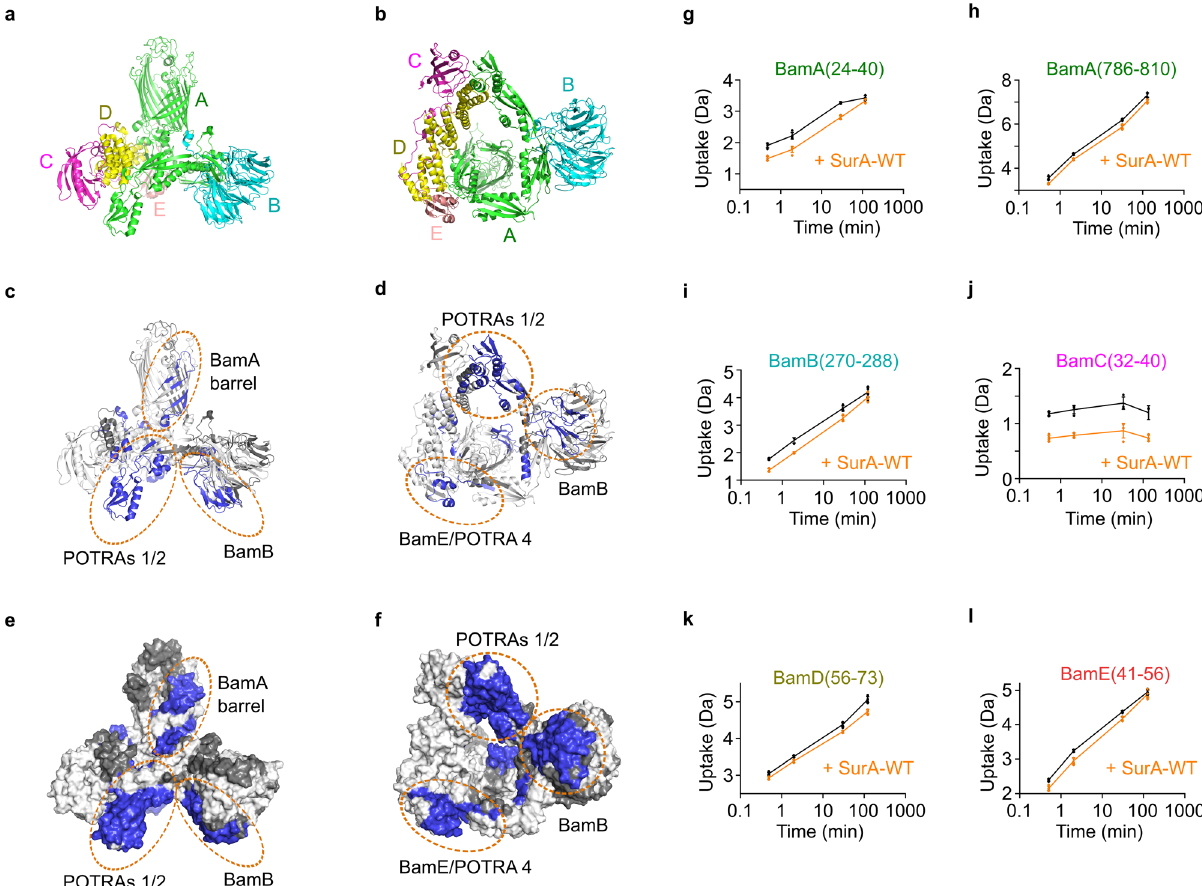
Fig. 2 HDX-MS analysis of BAM in the presence of SurA reveals multiple chaperone binding sites and allosteric conformational changes. a , b The structure of the BAM complex in the ‘ lateral-open ’ conformation (PDB: 5LJO 13 ) coloured by subunit. c , d Cartoon views and e , f surface views showing regions of HDX protection in the BAM complex upon binding SurA. Left panels show a side view of the complex, and right panels a view from the periplasmic face. Regions that are protected from hydrogen exchange in the presence of SurA are highlighted in blue. Regions in white show no change in deuterium uptake in the presence of SurA, while those in dark grey denote sequences for which peptides were not detected. Note that no regions showing deprotection from HDX upon SurA binding were observed. Patches of protection from HDX upon SurA binding in the BamA β -barrel domain (adjacent to the lateral gate), POTRAs 1 and 2, BamB, and BamE/POTRA 4 are ringed in orange. g – l Representative deuterium uptake plots for peptides from g , h BamA, i BamB, j BamC, k BamD, and l BamE. The extent of deuterium uptake (Da) in the absence (black) and presence of SurA (orange) is shown. Individual data points for each time point are shown as dots and error bars represent the standard deviation of three technical replicates. Source data are provided as a Source Data fi le (Supplementary Data